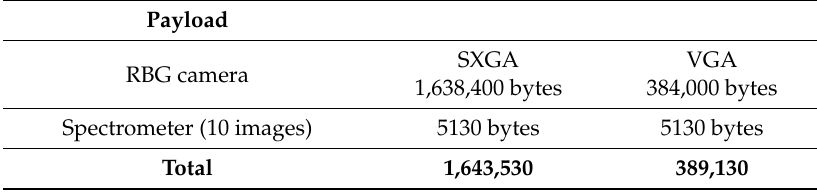
Table 1. Data Volume Generated by Mission Payloads.